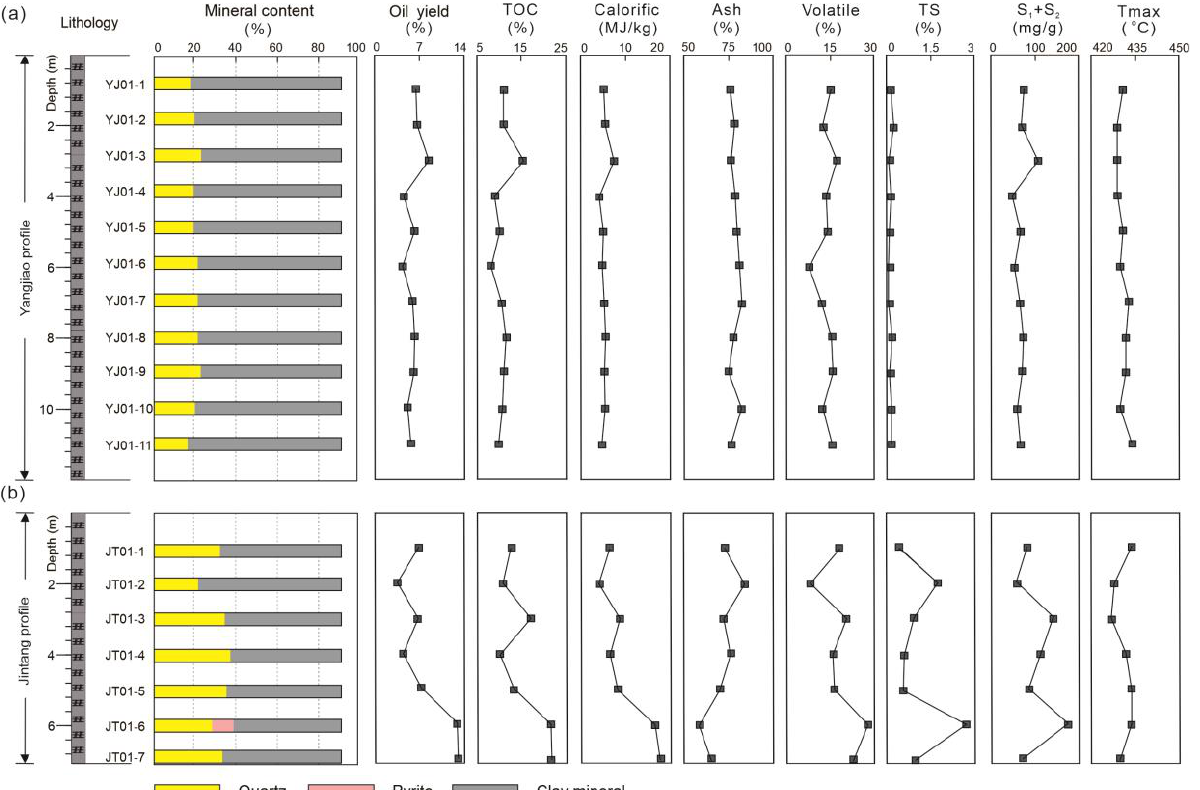
Figure 4. Mineral types and geochemical parameters of oil shale in Maoming Basin. ( a ): mineral types and geochemical parameters of oil shale in Yangjiao mining area; ( b ): mineral types and geochemical parameters of oil shale in Jintang mining area.